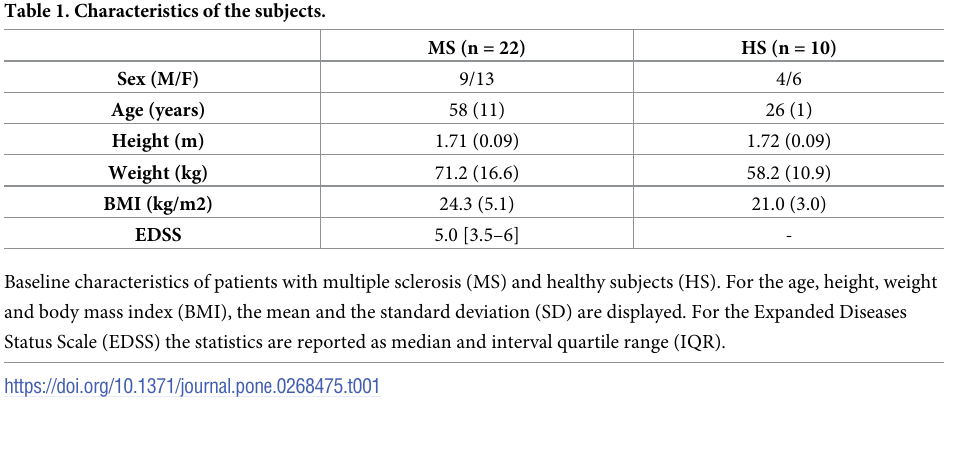
Table 1. Characteristics of the subjects.